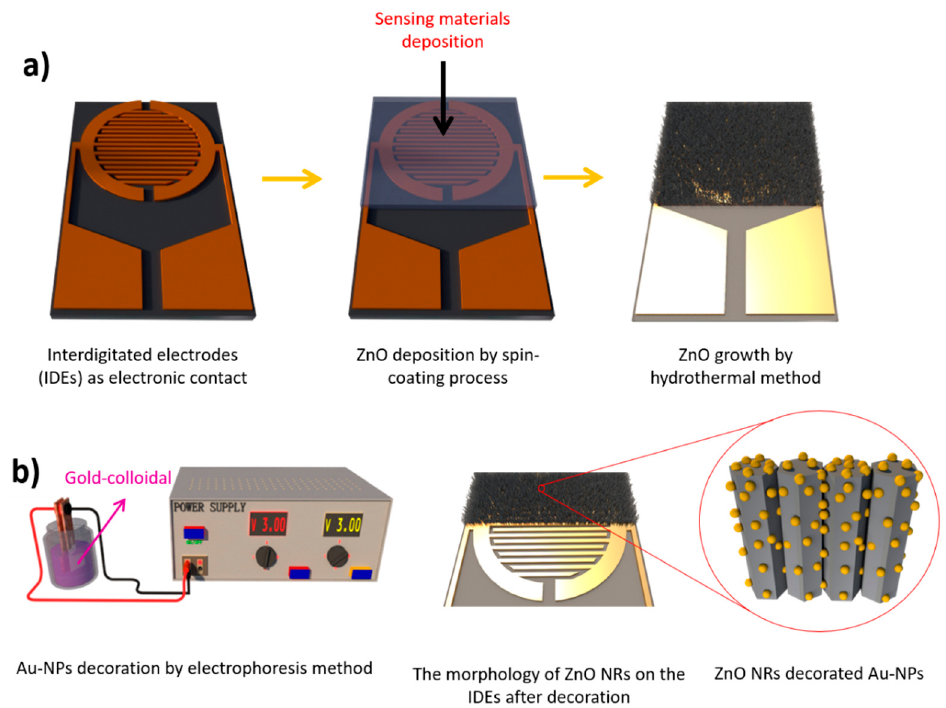
Figure 1. ( a ) Seed layer deposition on IDE by a spin-coating process followed by the growth process by hydrothermal method and ( b ) Au NP decoration by the electrophoresis technique.